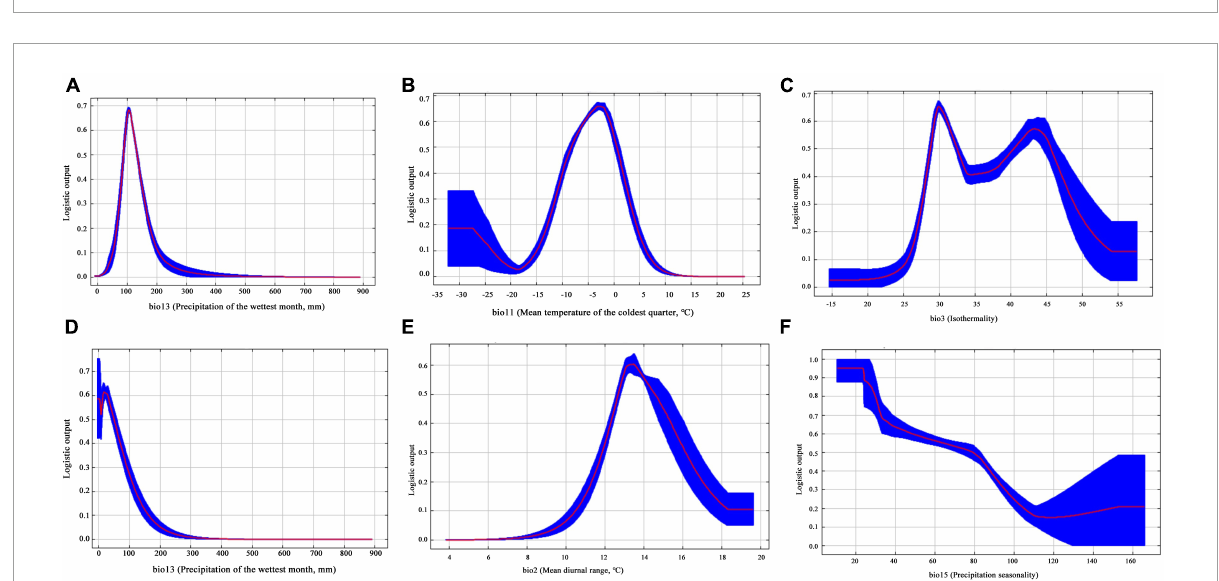
FIGURE3 Response curves of probability of presence of (A–C) H. r. sinensis and (D–F) H. r. turkestanica